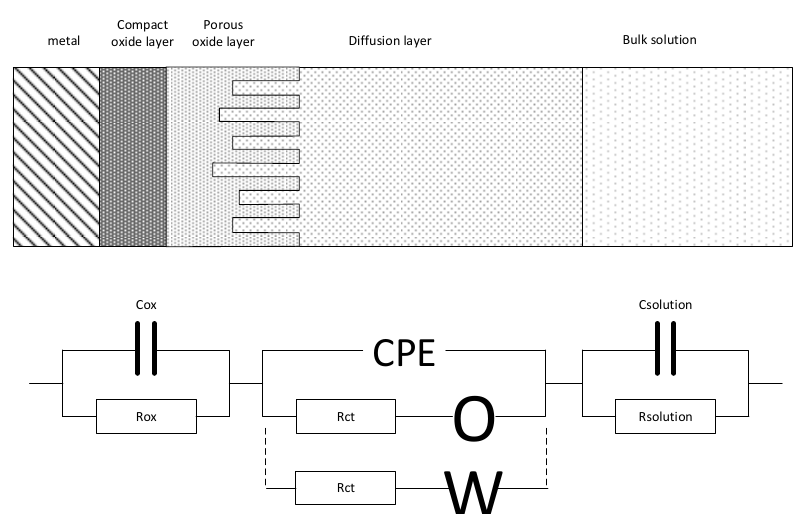
Figure 4. Equivalent circuit model for the metal-oxide-solution interface of Alloy 182 in high temperature water containing an oxide layer capacity (C ox ), an oxide resistance (R ox ), a charge transfer resistance (R ct ), a diffusion resistance for finite length diffusion layer ( O ) or a diffusion resistance for infinite length diffusion layer ( W ), a Constant Phase Element ( CPE ), a solution capacitance (C solution ) and a solution resistance (R solution ).